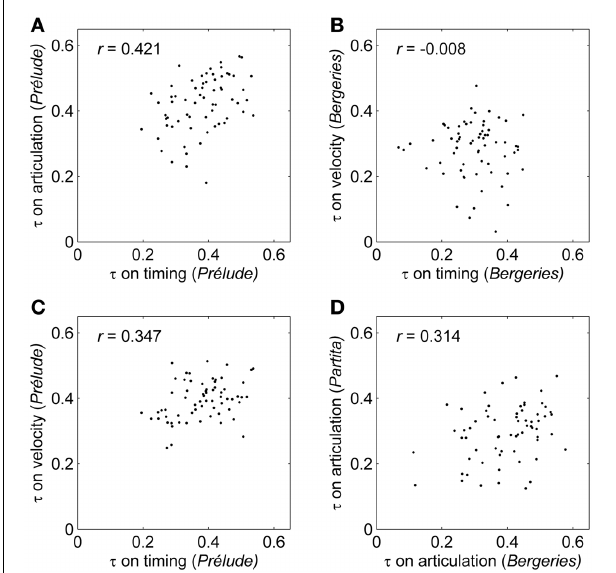
FIGURE 3 | Concordance between the pairwise correlations computed on expressive profiles. τ : Kendall’s tau correlation coefficient computed on expressive profiles between pairs of performers. r : Mantel correlation coefficient between similarity matrices. Each dot corresponds to the pairwise correlation between two performers. (A) Timing and articulation pairwise correlations for the Prélude . (B) An example of a non-significant association between the timing and velocity pairwise correlations for the Bergeries . (C) Timing and velocity pairwise correlations for the Prélude . (D) Pairwise correlations on the articulation profiles for the Bergeries and the Partita